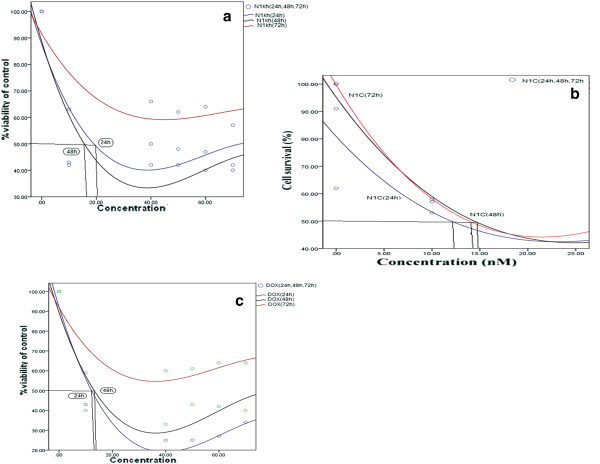
IC50 of (a) the doxorubicin-loaded linear PNIPAAm-MAA-grafted magnetic nanoparticles (b) the doxorubicin-loaded cross linker PNIPAAm-MAA-grafted magnetic nanoparticles (c) Pure doxorubicin on A549 tumor cell line after 24, 48 and 72 h treatment.